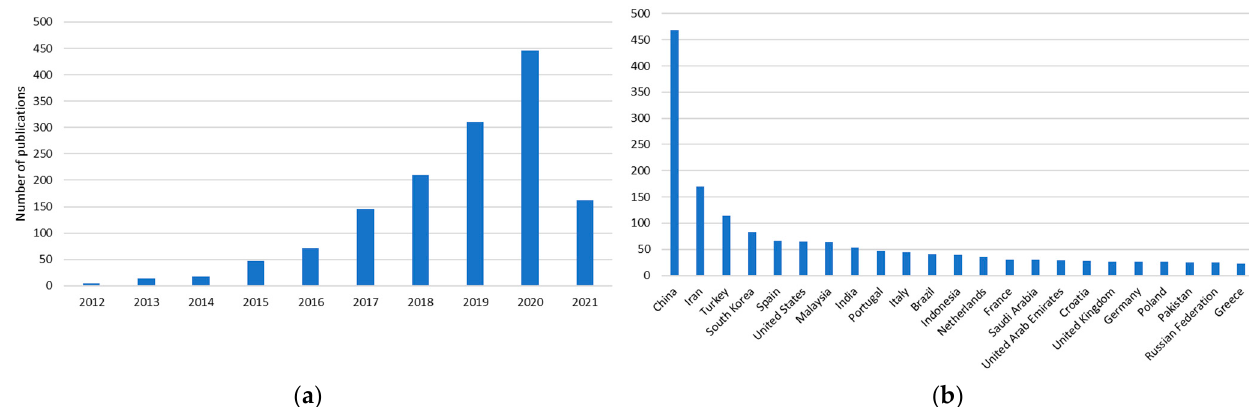
Figure 1. ( a ) Number of articles published since 2012 regarding the use of DES as extraction solvents; ( b ) geographical distribution of the countries where the research concerning DES was conducted. (Data on scopus.com using the keywords “deep eutectic solvents extraction”, accessed on 18 March 2021.)